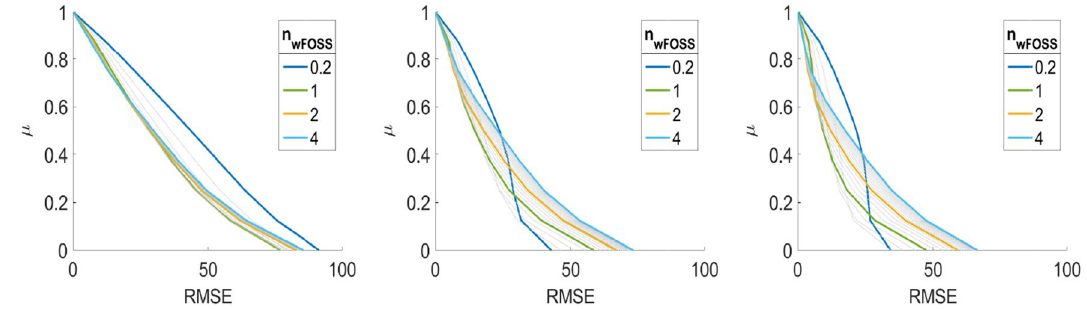
Fig. 10 Branin function: Average RMSE over the 𝛼 -cuts of the result space for the DACE model with 100 underlying FOSS sampling plans with 4 (left), 9 (center), and 16 (right) sampling points